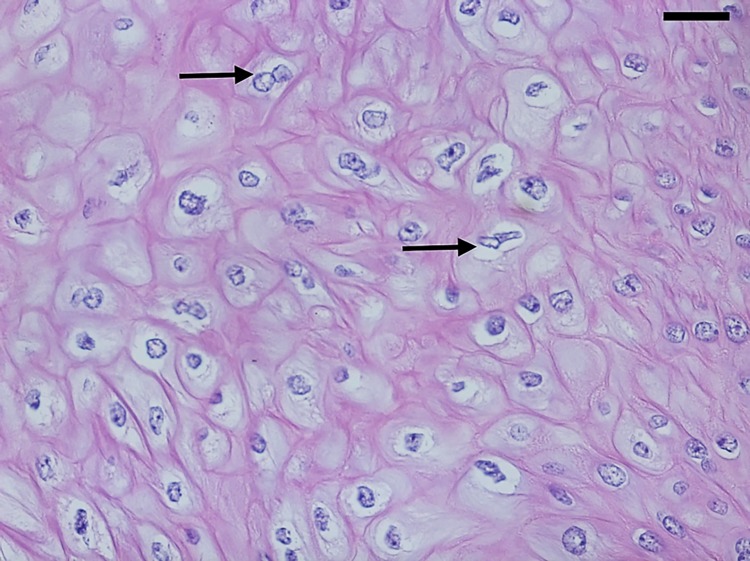
Histopathology of patient's penile tissue, stained with hematoxylin-eosin.Arrow indicates presence of koilocytosis. 1000× magnification.